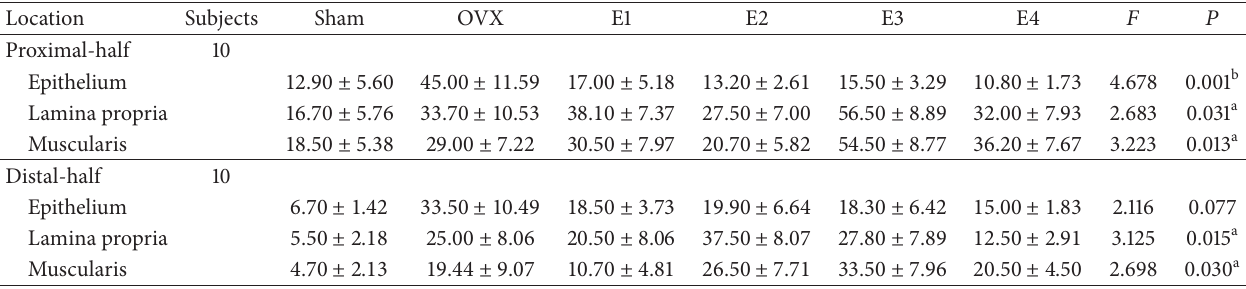
Table 3: Index of the percentage of vaginal ER 𝛼 -immunoreactive cells (ER 𝛼 %) according to location in all groups ( 𝛼 = 0.05 , two-tailed). Location